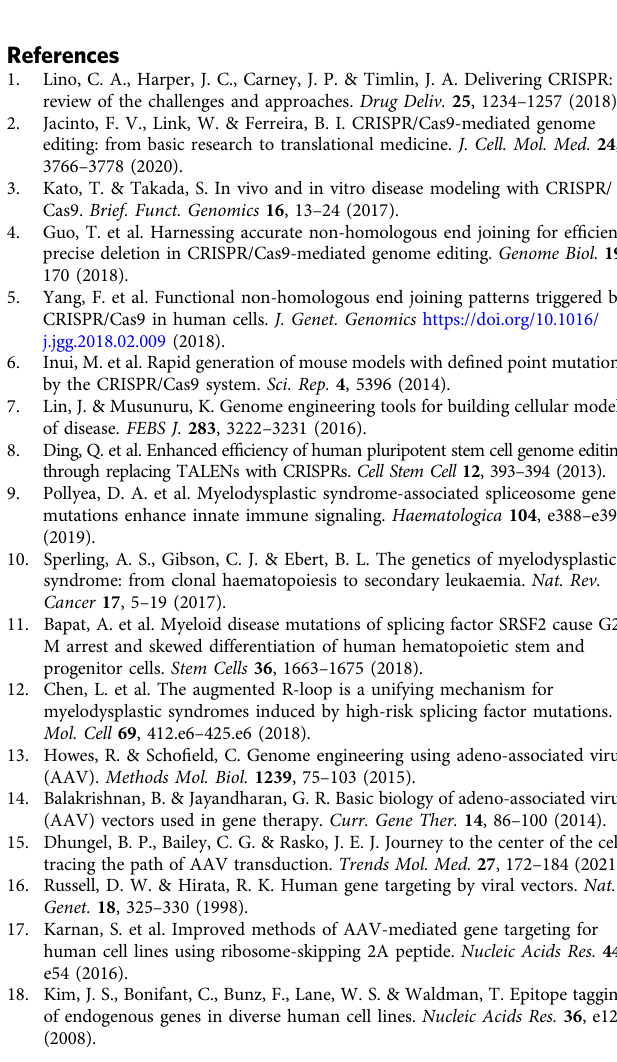
Table S1. For a more easy-to-follow protocol version format, the reader may refer to https://www.protocols.io/edit/high-ef fi ciency-gene-editing-using-adeno-